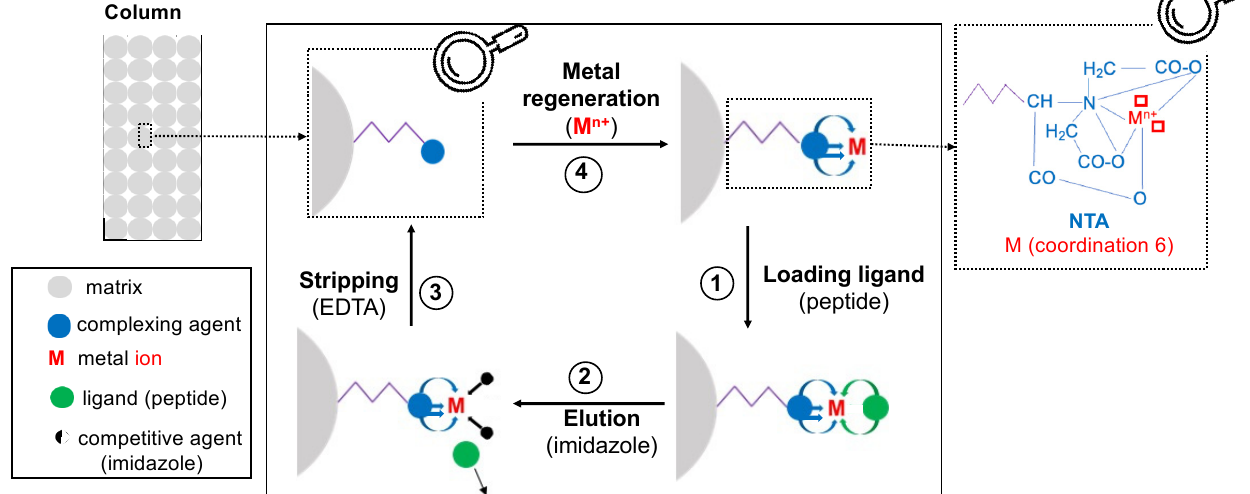
Figure 3. The Main steps involved in immobilized metal ion affinity chromatography: 1. Loading the ligand; 2. Elution of the ligand; 3. Stripping of the metal on column; 4. Metal regeneration on the column (figure adapted from thesis manuscript [105]).